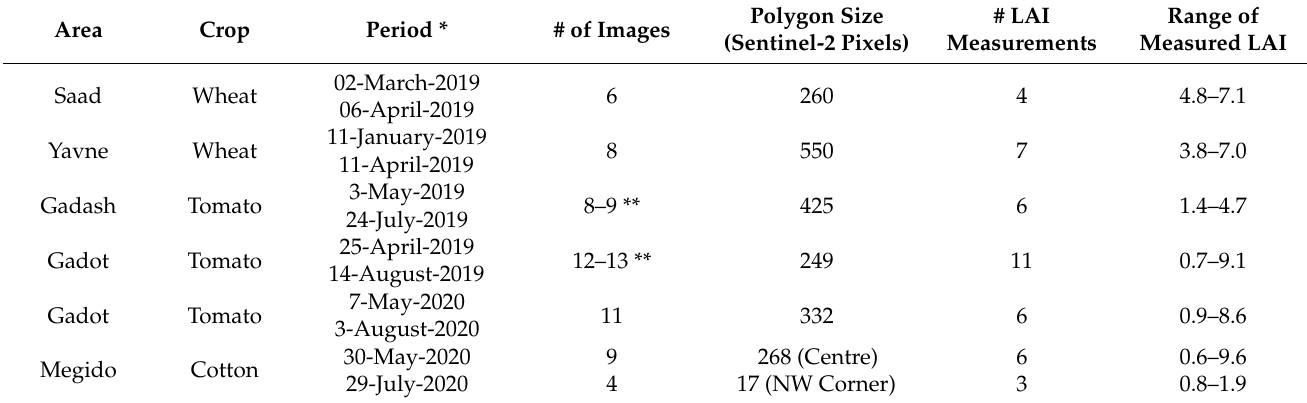
Table 2. Sentinel-2 imagery and LAI measurements used in the